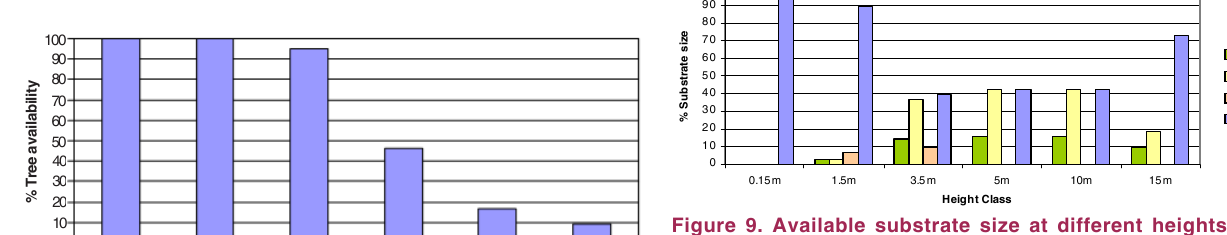
Figure 9. Available substrate size at different heights of the vertical axis at Kottawa Arboretum